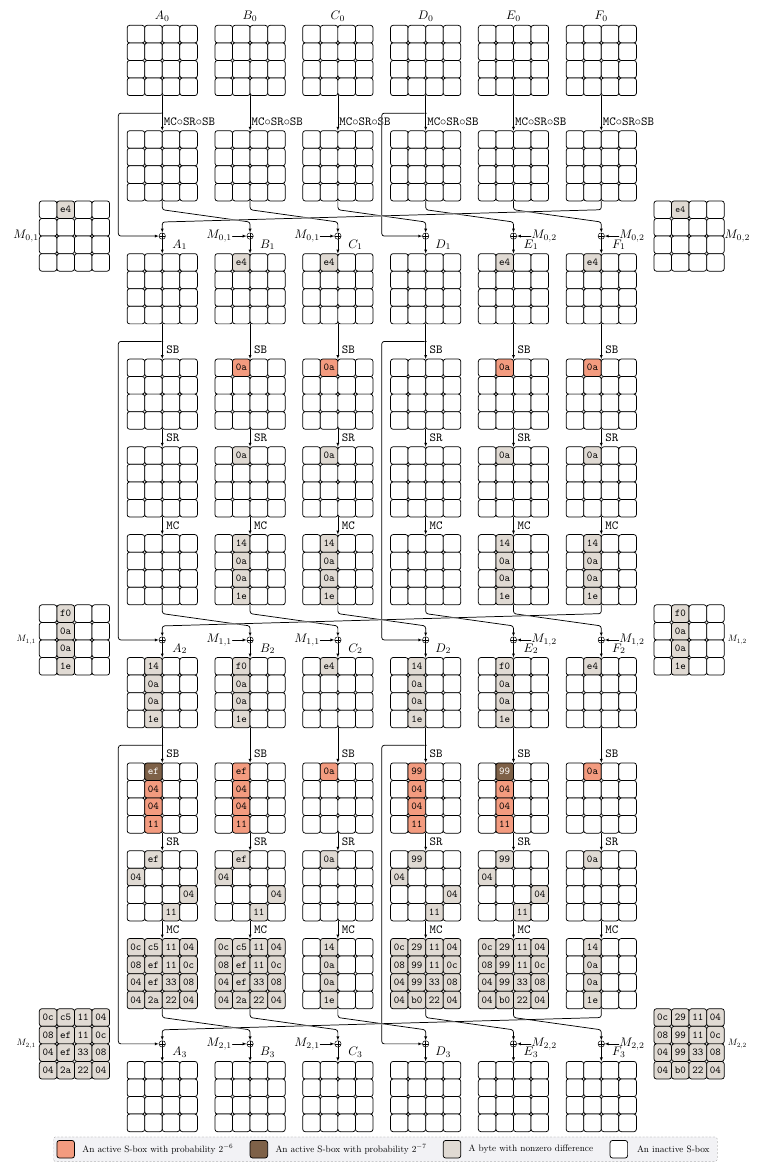
Figure 12: 3-step differential characteristic of probability 2 − 134 for C1